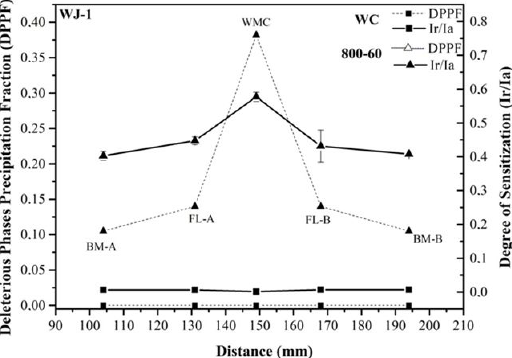
Figure 12. DOS (Ir/Ia ratio) and deleterious phases volume fraction as a function of the analyzed region for the WJ1-60 sample.